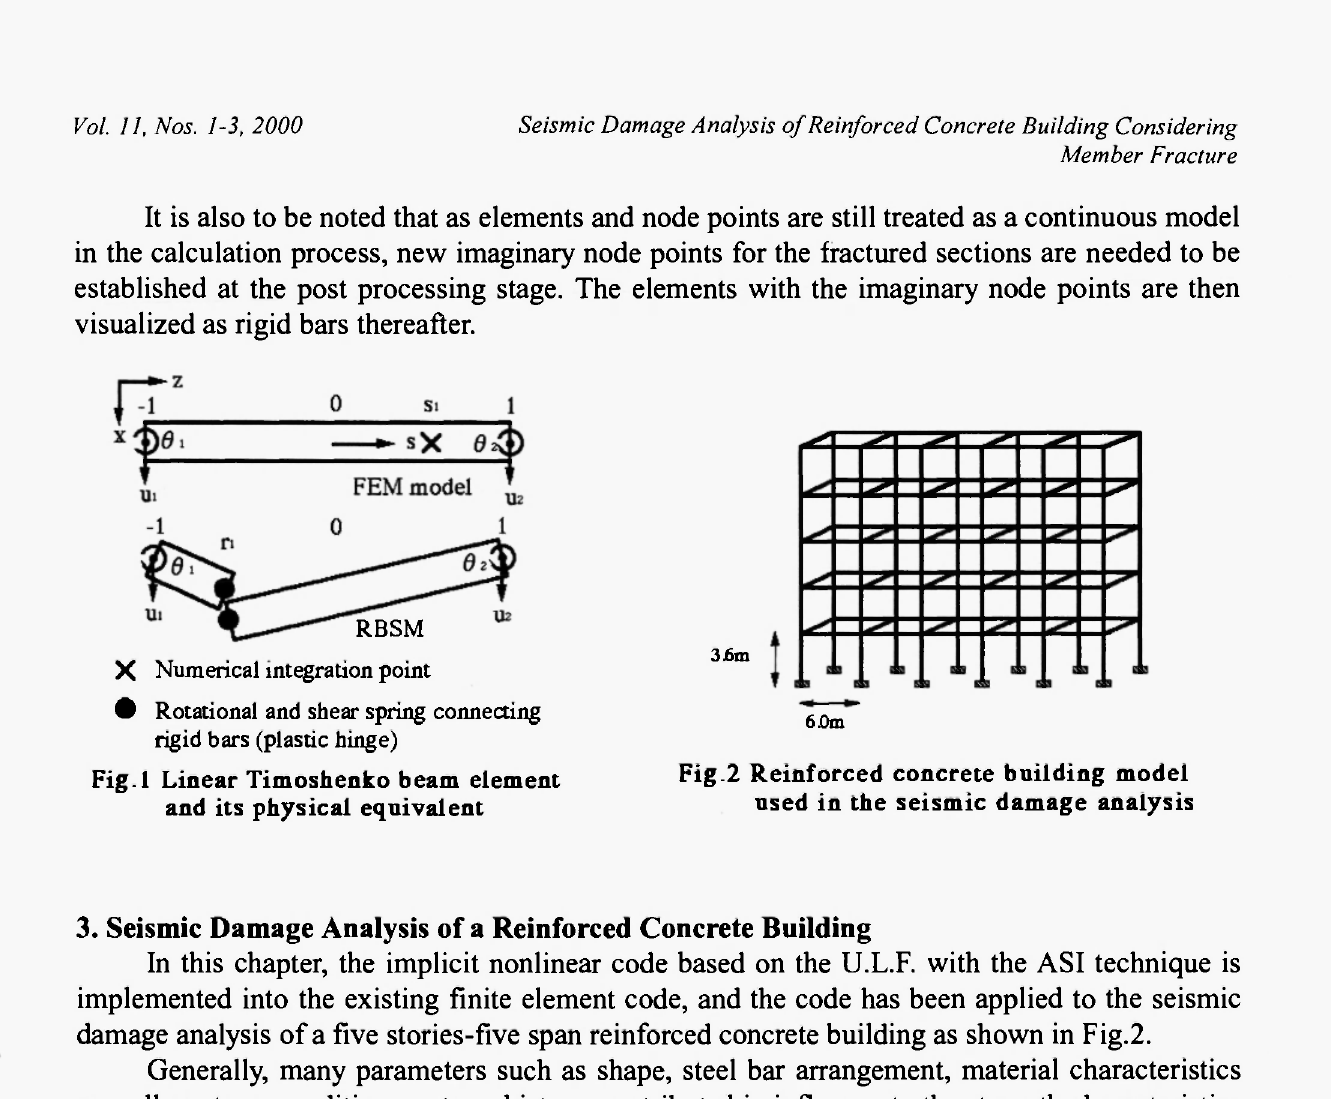
Fig.l Linear Timoshenko beam element and its physical equivalent